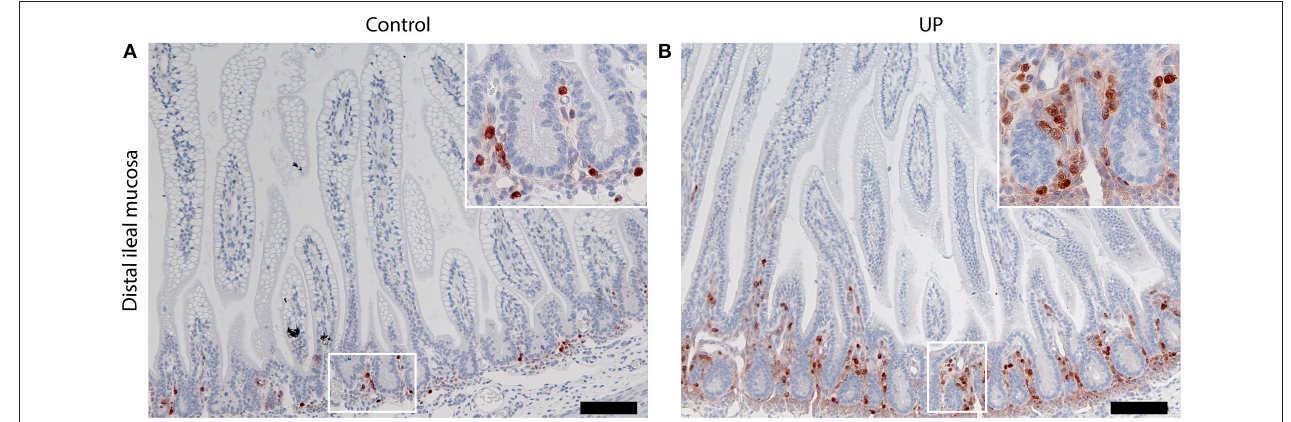
FIGURE 2 | Intra-amniotic UP-exposure leads to gut inflammation. (A) In control fetuses, MPO-positive cells were predominantly located in the lower crypt region. (B) Six days after intra-amniotic UP-exposure, increased numbers MPO positive cells were observed in the lower crypt. In addition, influx of MPO positive cells into the villi was observed following UP-exposure, which was absent in non-infected historical controls. Images were taken at 100 times magnification, scale bar represents 200 µ m. Insert images were taken at 400 times magnification. MPO, myeloperoxidase; UP, U. Parvum